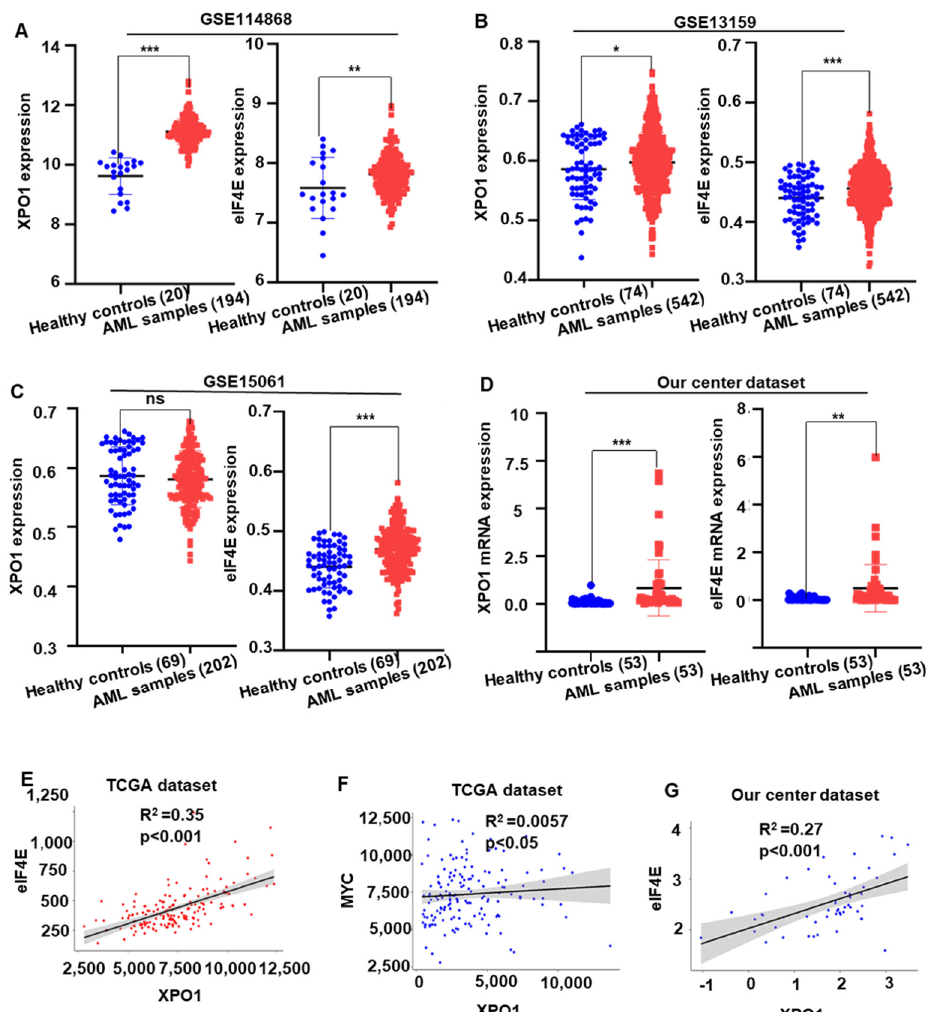
Figure 5. XPO1/eIF4E was highly expressed and correlated in AML patients. ( A ) Gene expression of XPO1 and eIF4E in AML patients (n = 194) and healthy donors (n = 20) extracted from the GEO (GSE11486) database. ( B ) Gene expression of XPO1 and eIF4E in AML patients (n = 542) and healthy donors (n = 74) from the GEO (GSE13159) database. ( C ) Expression of the XPO1 and eIF4E genes in AML patients (n = 202) and healthy donors (n = 69) from the GEO (GSE15061) database. ( D ) In our institute’s cohort research, blood samples from AML patients (n = 53) express greater levels of XPO1 and eIF4E than samples from healthy donors (n = 53). ( E − G ) the association between XPO1 and eIF4E in the TCGA dataset and the dataset from our institute. * p < 0.05, ** p < 0.01, *** p < 0.001, ns : p >0.05